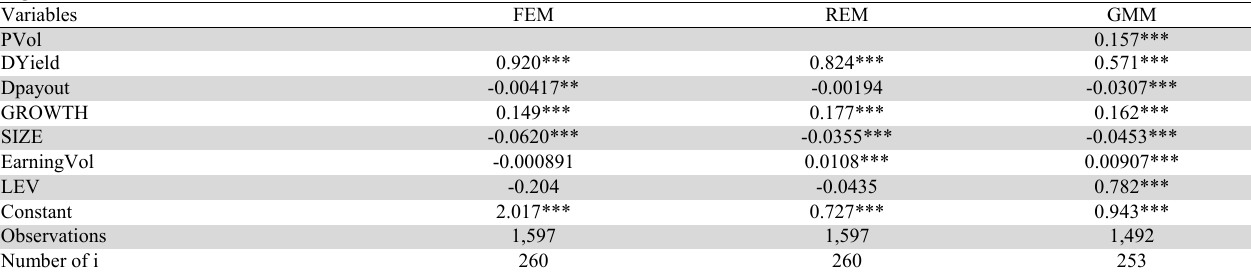
Regression results